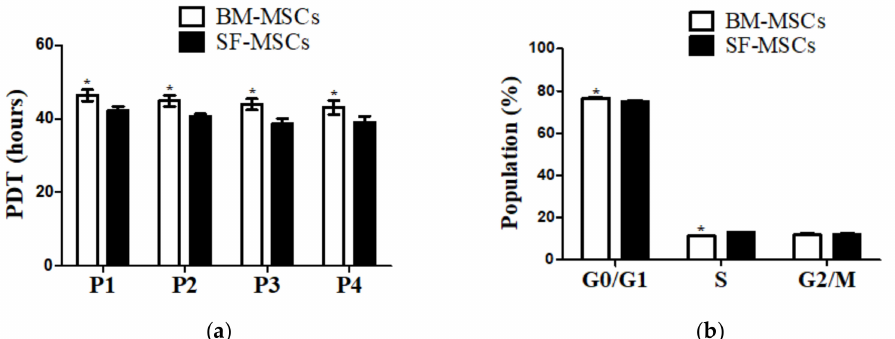
Figure 2. Cell cycle and proliferation capacity of bone marrow (BM-MSCs) and synovial fluid (SF- MSCs) from the camel. ( a ) The proliferation capacity was evaluated by population doubling time (PDT) assay. SF-MSCs showed increased proliferation capacity compared to BM-MSCs during the passage. ( b ) Cell cycle analysis indicated that cell arrest and DNA replication were significantly increased in SF-MSCs compared to BM-MSCs. Bar graphs illustrate mean values +/ − SD ( n = 4). * denote significant ( p < 0.05) differences (P1, P2, P3, and P4: passage 1, 2, 3, and 4; G0/G1: G0/G1 phase; S: S phase; G2/M: G2/M phase).